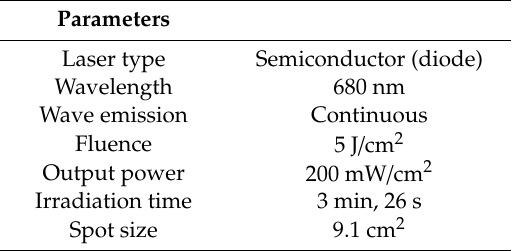
Table 3. Laser parameters employed in the present